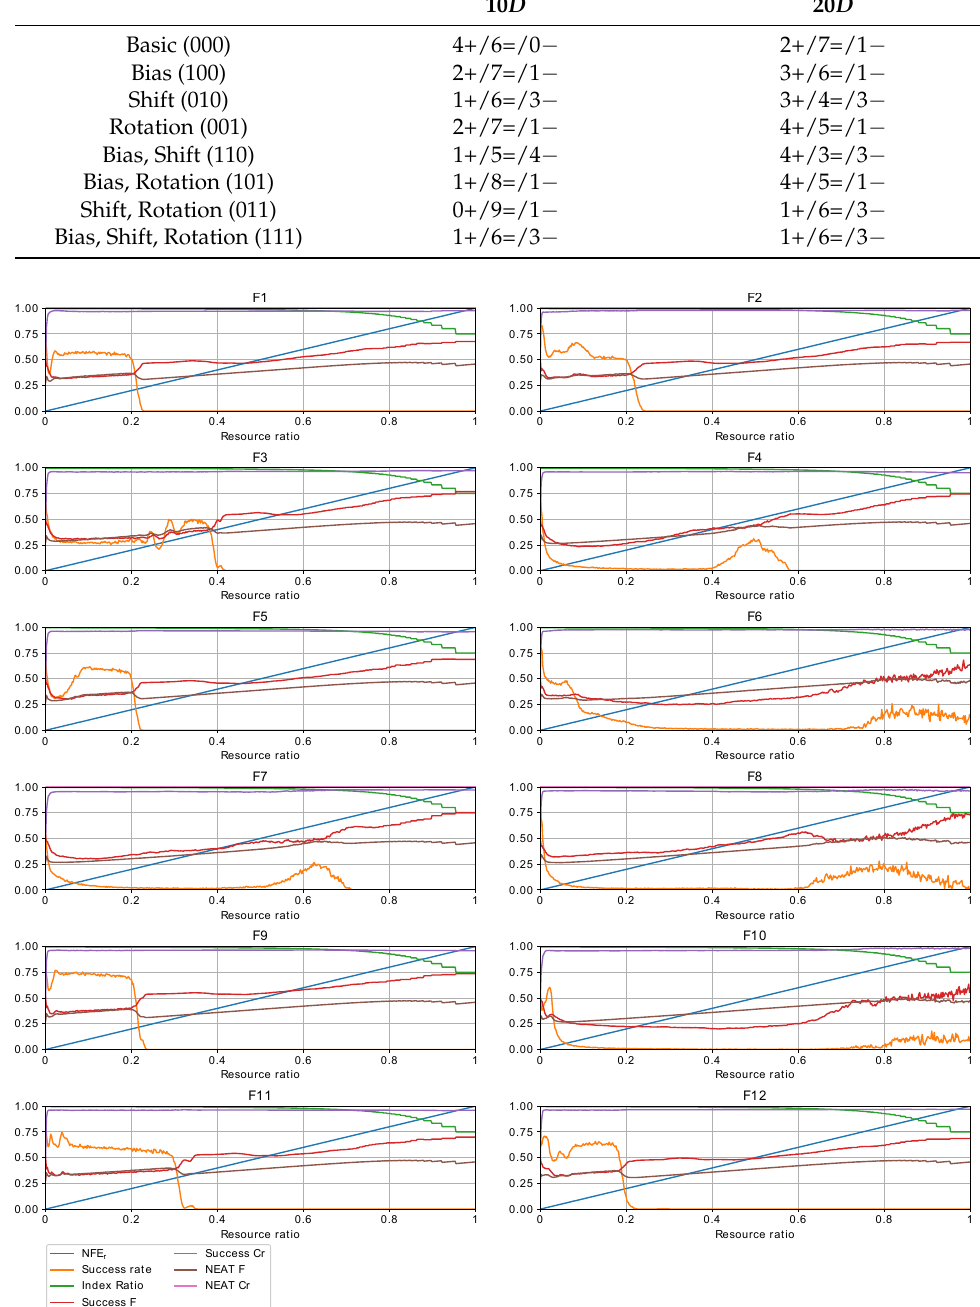
Figure 1. Process of parameter adaptation with solution from run 29, CEC 2022 test functions, 10 D